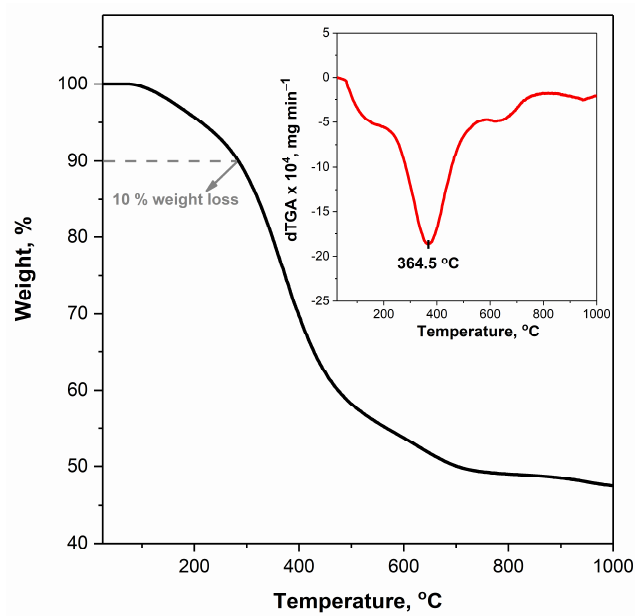
Figure 15. Experimental weight loss vs. T curves for thermal decomposition of VCOP-1 copolymer, black curve (insert, dTGA vs. T, red curve).